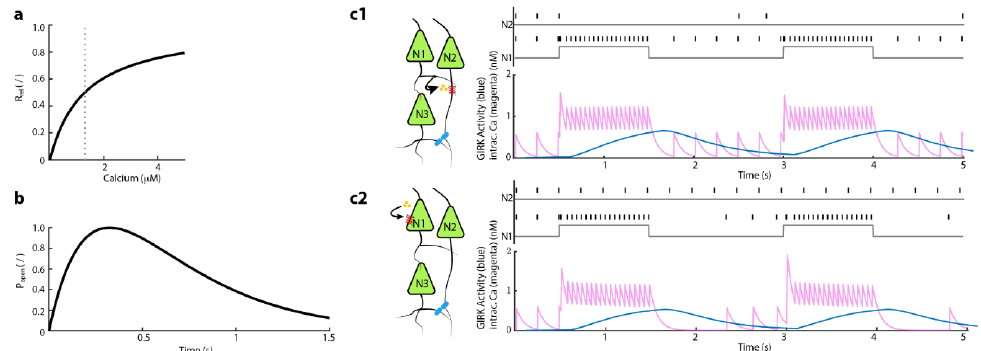
Figure 4. Simulation of spike rate from two LC neurons with a built-in NE-dependent GIRK activity leads to a reduced spiking rate in LC neurons that are connected via dendro-somatic synapses or a somatic release that retroact onto the secreting LC neuron. ( a ) R rel is the release fraction that is dependent on the level of presynaptic calcium at the time of action potential. The gray vertical line is the amount of calcium accumulated in a cell when firing at 20 Hz. The relation is defined by Equation (8). ( b ) P open shows the effective time course of the opening and closing of the synaptic conductance of GIRK channel (Equation (9) P open ( t )). ( c1 ) Depicts a simulation scenario where neuron 1 (N1) connects to neuron 2 (N2) via dendro-somatic synaptic interaction. The upper diagram shows the spike rates of N1 and N2 throughout the simulated 5-s. Here, the gray line represents the time course of current injections (1 s, I = 270 nA) in the respective neuron. The lower diagram shows the development of intracellular calcium levels in N1 (magenta) during a phasic-like activation; the blue line represents the time course of GIRK conductance in N2. ( c2 ) Cartoon illustrates the autoinhibition scenario in which alpha2-adrenergic autoreceptors in N1 activate through local NE-release from the soma. One-second bouts of current injections (I = 270 nA) led to an increased spike rate in N1, while N2 displays a spontaneous firing pattern (upper diagram). The lower diagram shows time courses of intracellular calcium concentration and GIRK conductance in N1.